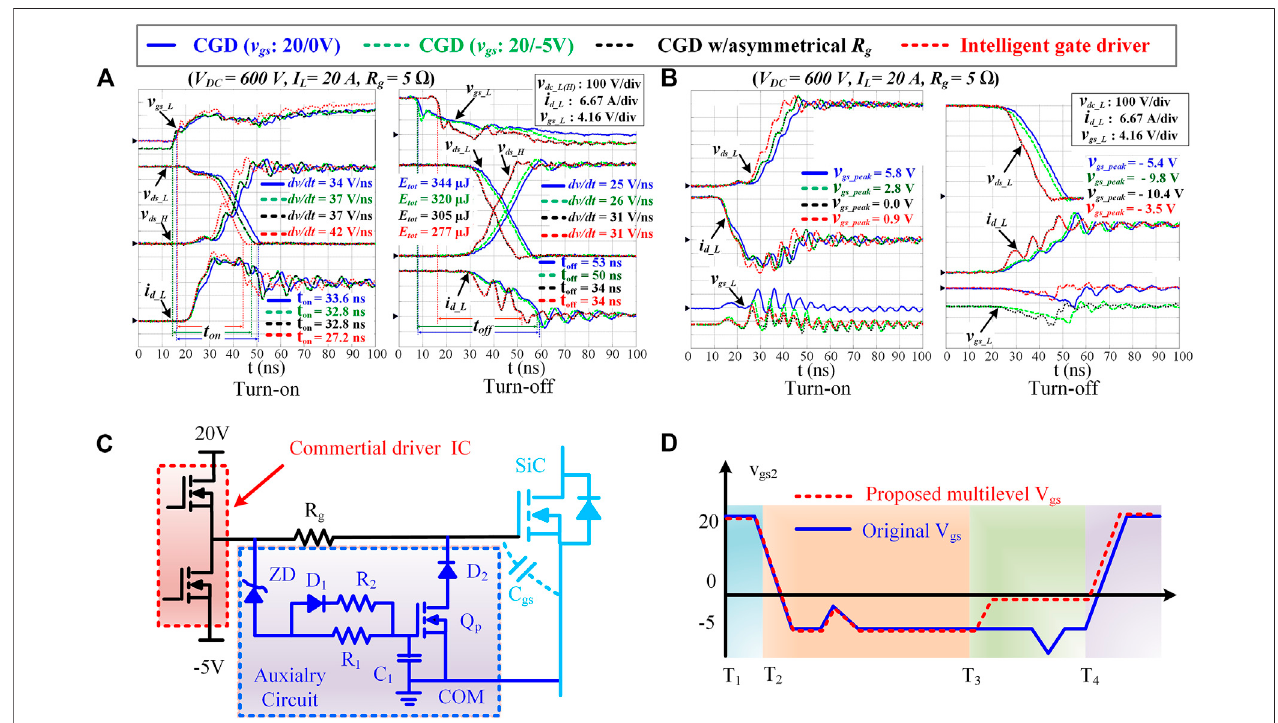
FIGURE 7 | (A) Switching performance comparison of different conventional gate drivers (CGDs) with intelligent gate driver (B) Cross-talk comparison of conventionalgatedriversandintelligentgatedriver(Zhangetal.,2017) (C) Circuitdiagramofmultilevelgatedriver (D) Waveformcomparisonofmultilevel V gs andoriginal V gs (Li et al., 2020b).